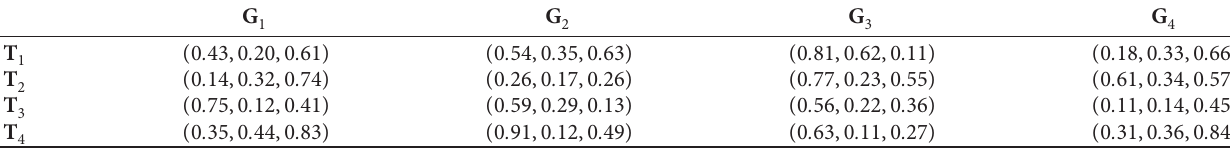
Table 1: Information given by an expert in TSFSs.